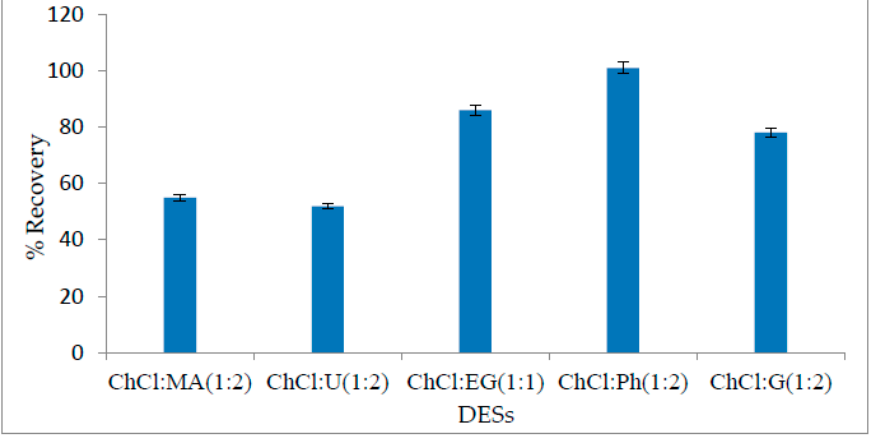
Figure 2. Selection of the DES for maximum % recovery. Analyte concentration-20 µ g/L; buffer volume-2 mL (pH = 6); sample volume-20 mL; DES volume-500 µ L; THF volume-300 µ L; temperature- 25 °C; sonication time-2 min; centrifugation time-1 min.